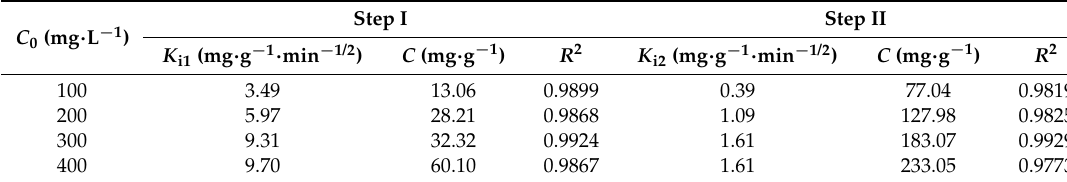
Table 2. Parameters of intra-particle diffusion model for MB adsorption.